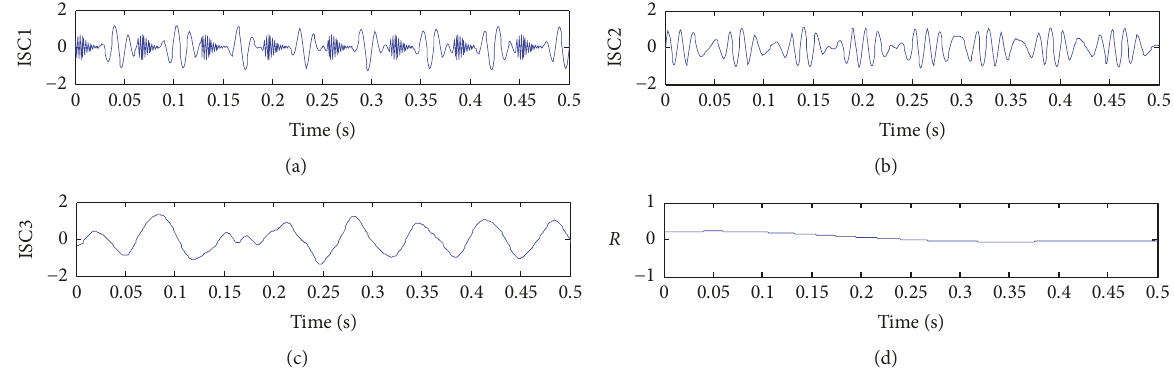
Figure 3: Simulation signal LCD